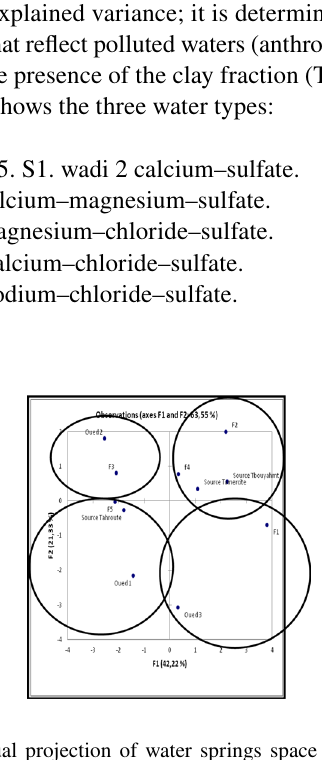
Fig. 9 Individual projection of water springs space (factorial